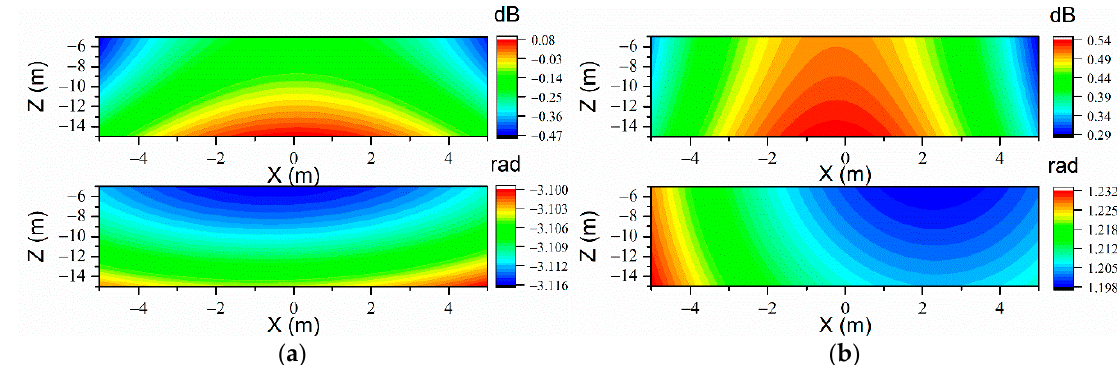
Figure 9. The sound prediction errors of CMESM on the prediction plane when 90 uniformly arranged measurement points are used at the frequency of 71 Hz. ( a ) Free field ( L 1 = 55, upper: p E ; lower: ϕ E ) and ( b ) h U = 0.2 m ( L 1 = 62, upper: p E ; lower: ϕ E ). Table 3. Different acoustic radiation mode (ARM) truncation numbers in compressed modal equivalent source method (CMESM) for 90 measurement